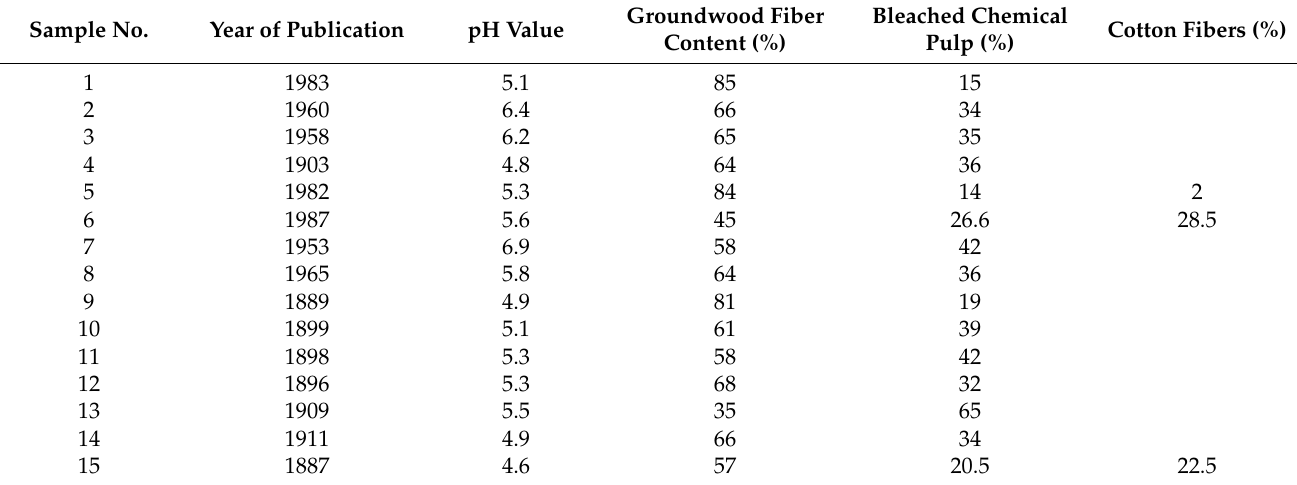
Table 1. List of real paper samples, publication years, pH values, and fiber furnish analysis. The pH values are calculated from two measurements with an average standard deviation of 0.1 pH units. Sample